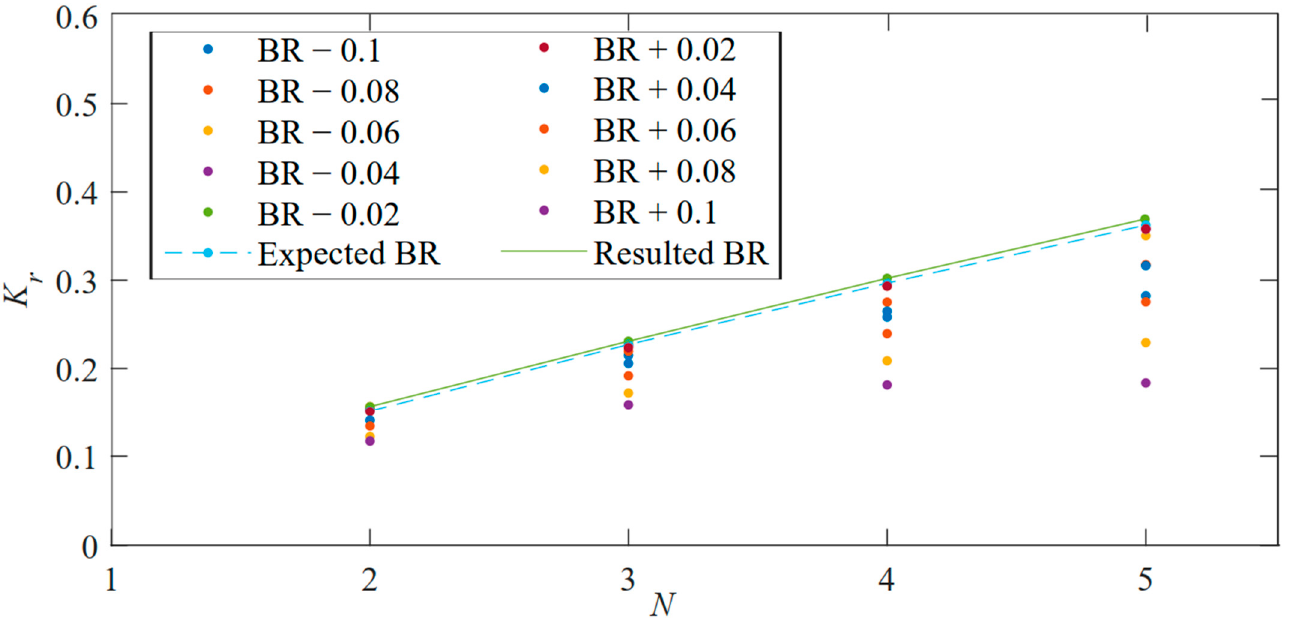
Figure 15. Bragg resonance of multiple periodically submerged breakwater with 1.0 m wavelength at 0.3 m water depth.